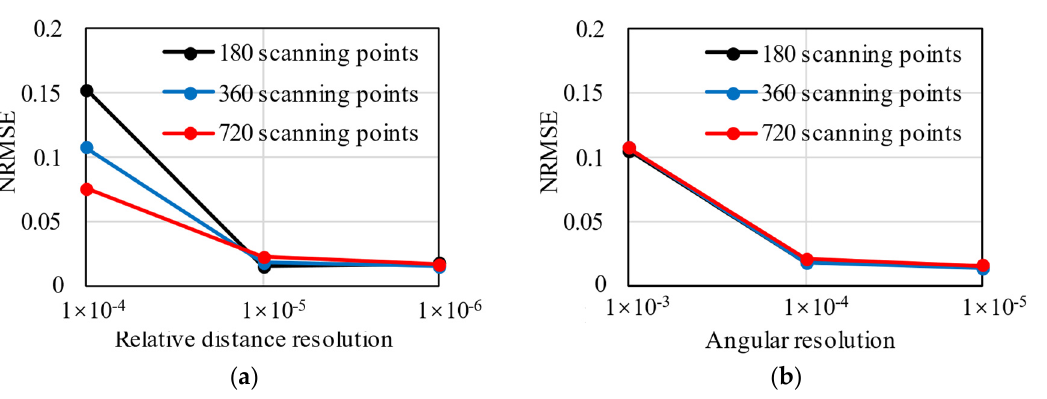
Figure 8. The NRMSE of hybrid analysis for various relative distance resolutions ( a ) and various angular resolutions ( b ).